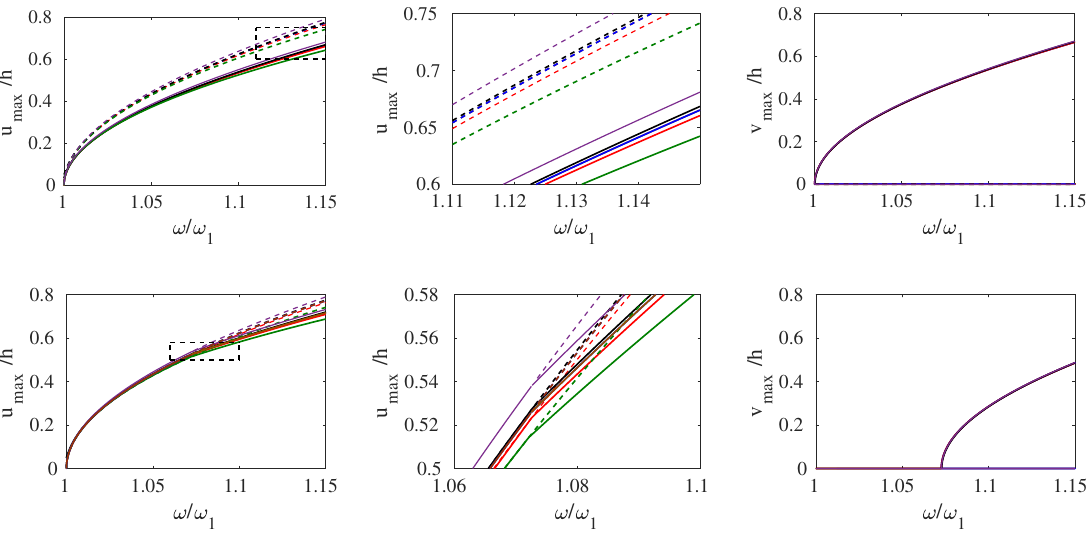
Figure 9. Backbone curves of the clamped–clamped beam in 1:1 resonance. First row: without detuning, second row: with detuning. Left column: first polarization in the u direction, center column: zoom, right column: second polarization in the v direction. Comparison of the full-order reference solution (black line) to reduced-order models (ROMs) with two master modes; purple: ICE, blue: QM–SMD, brown: QM–MD, red: DNF. The green curve represents the analytical